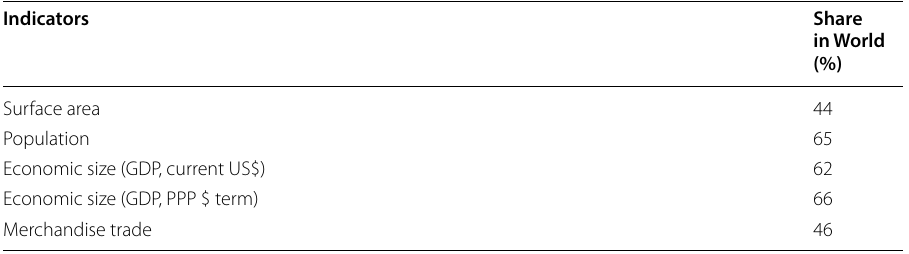
Table 1 Indo-Pacific’s share in the World, 2017. Source: Authors’ calculation based on